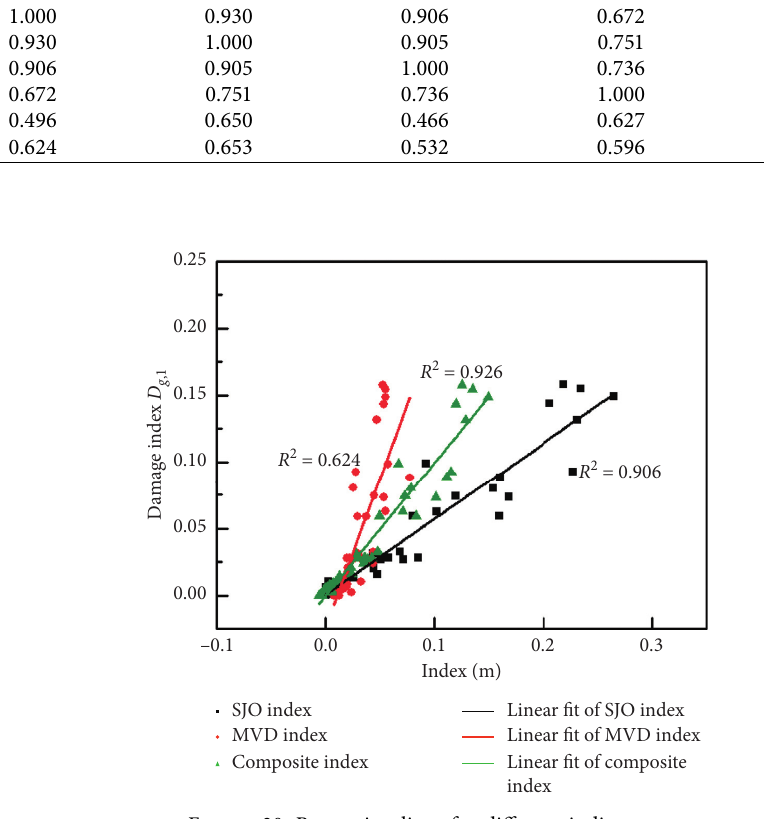
Figure 20: Regression lines for different